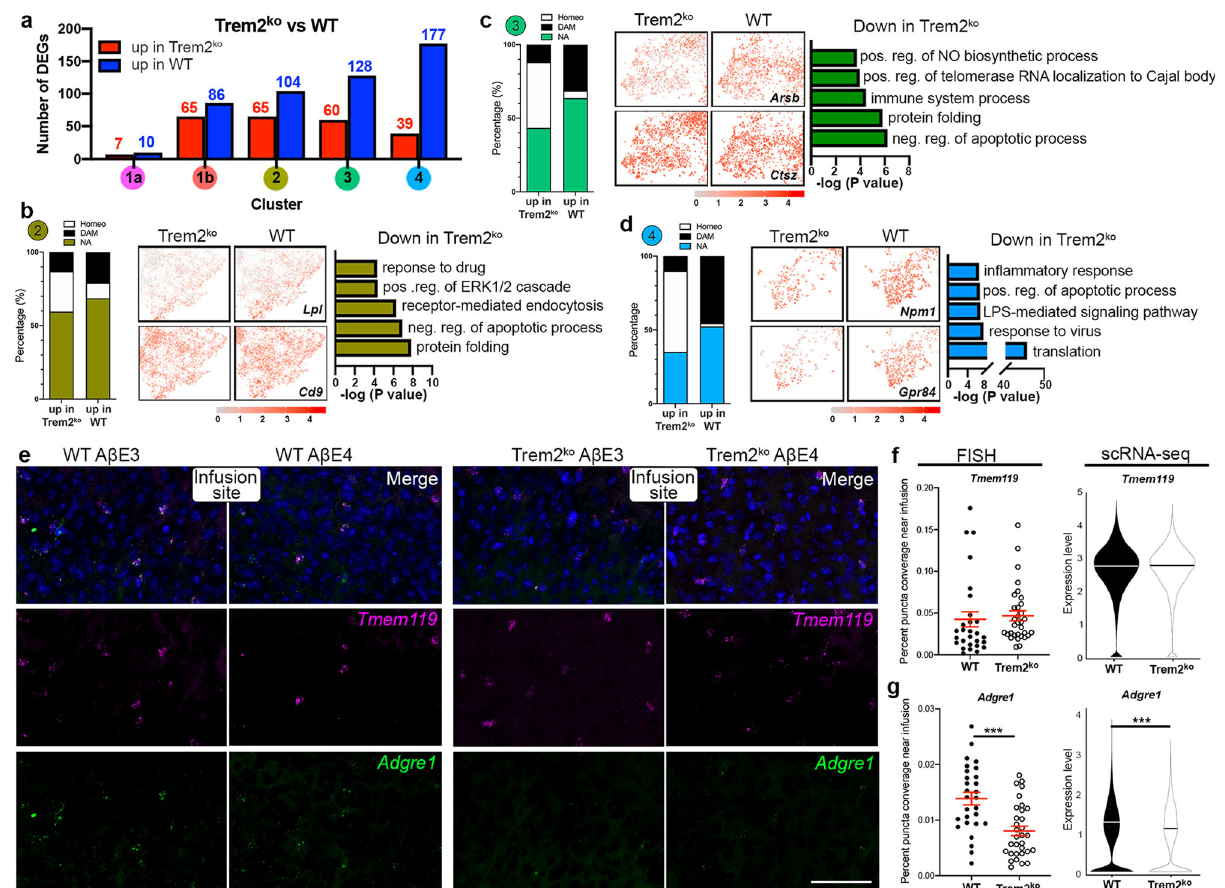
Fig. 6 scRNA-seq identi fi es activated gene clusters downregulated in Trem2 ko mice following A β E3 or A β E4 infusions. a The number of DEGs in Trem2 ko compared to WT in each cluster (Bonferroni-corrected p value <0.05 and natural logFC >0.1). b – d The proportion of homeostatic (Homeo) or DAM genes among DEGs in Trem2 ko or WT groups in clusters 2 ( b ), 3 ( c ), and 4 ( d ). Feature plots (Left) showing representative genes and bar plot (Right) showing top fi ve GO terms that are signi fi cantly downregulated in Trem2 ko compared to WT microglia in the three infusion responsive clusters. n = 4 per group (WT and Trem2 ko ). e – g The expression of Tmem119 and Adgre1 was spatially visualized at 200 μ m perimeter from the injection site. e Representative images of FISH analyses of microglial gene expression near the A β infusion site. ( Tmem119 – pink, Adgre1 – Green, Nuclei – Blue). Scale bar = 50 µ m. f , g Scatter dot plots showing the area of puncta coverage adjacent to the infusion site along with violin plots of the expression of the same gene in the scRNA-seq dataset for Tmem119 ( f ), and Adgre1 ( g ). n = 8 mice per group (equal males and females), with four infusion sites analyzed per animal, red lines represent mean ± SEM, *** p < 0.001 ( p = 0.0001) using two-tailed unpaired t